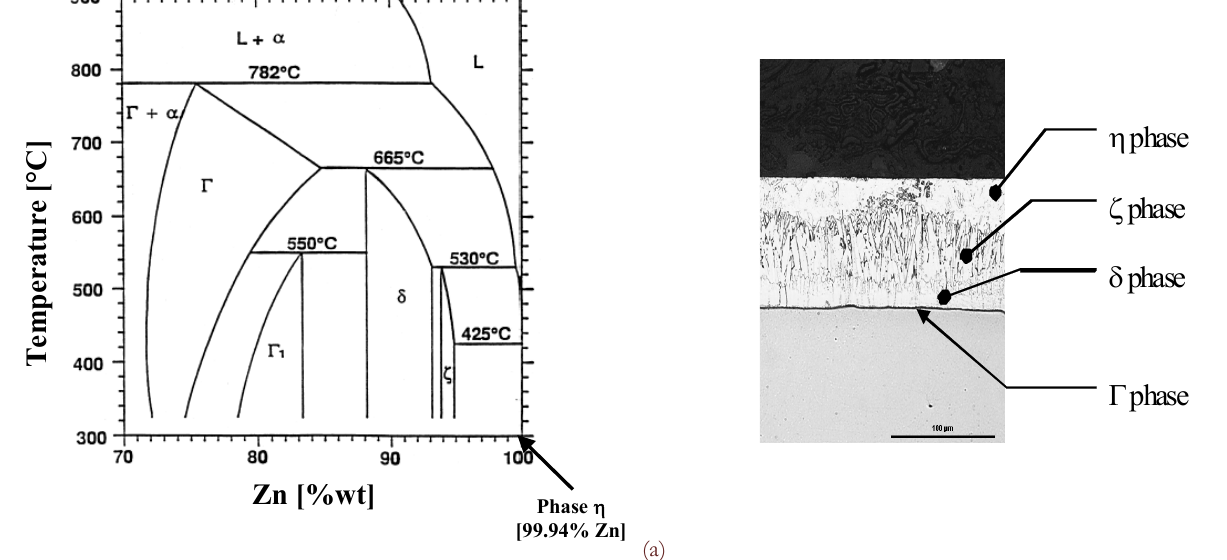
Figure 1: Intermetallic phases in a traditional hot dip galvanizing coating: a) Zn-Fe status diagram portion [1], b) Morphological aspects of intermetallic